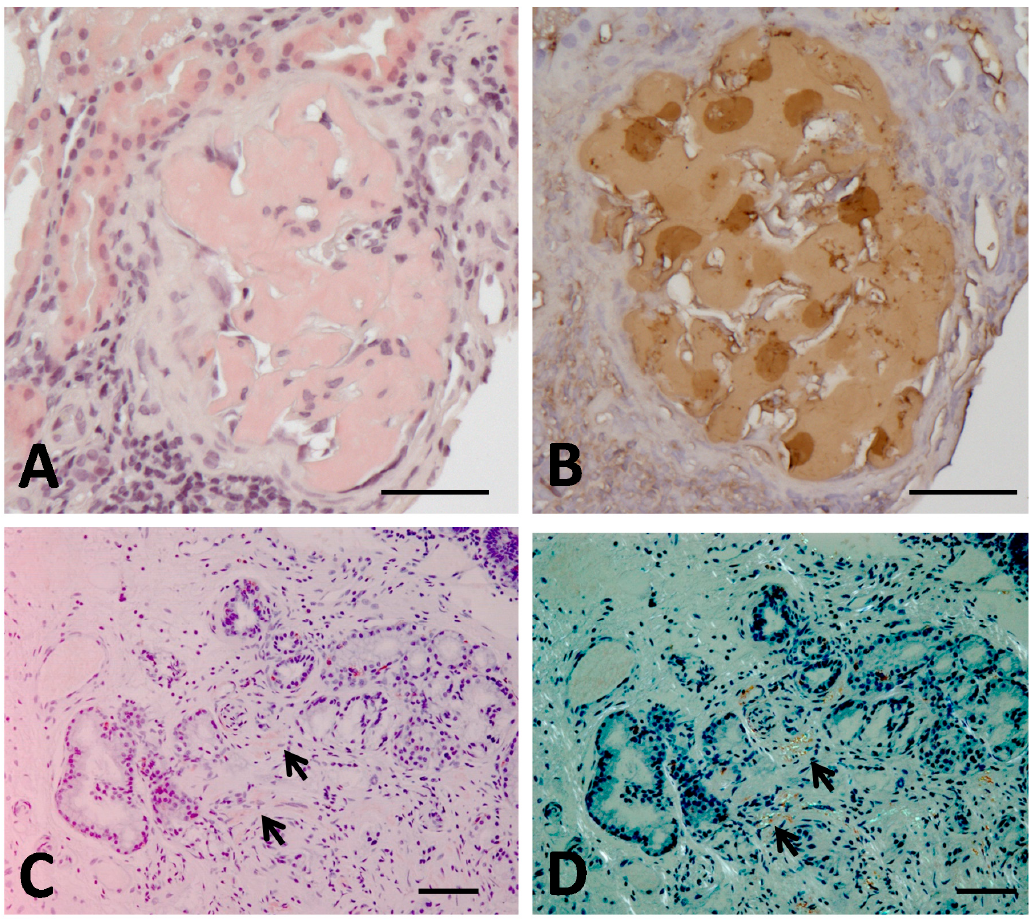
Figure 1. Findings of renal biopsy ( A , B ) and duodenal mucosal biopsy ( C , D ) in a Japanese A α -chain amyloidosis patient [14]. ( A , C ) Congo red staining. ( B ) Immunohistochemical staining with anti-human fibrinogen antibody. ( D ) Congo red staining under polarized light. Renal biopsy at the age of 32 years shows heavy amyloid deposits mainly in glomerulus with almost complete obliteration of the normal glomerular architecture ( A ). The positive staining is observed in immunohistochemistry ( B ). Duodenal mucosal biopsy at the age of 40 years demonstrates a small amount of amyloid deposits (arrows, ( C )), showing typical apple-green birefringence under polarized light (arrows, ( D )). Bars = 50 μ m.